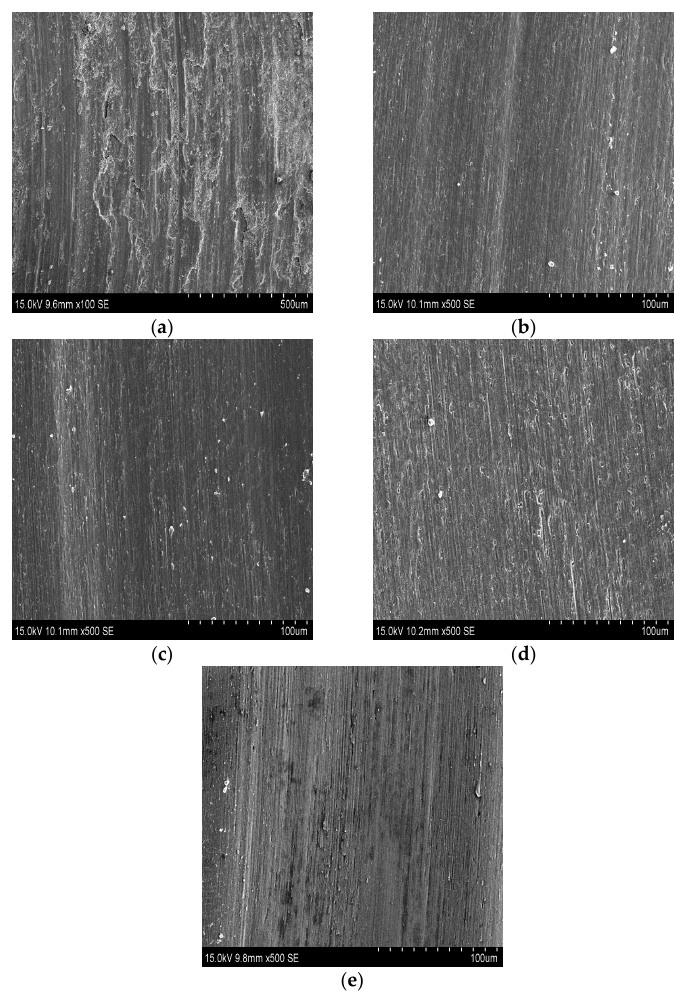
Figure 11. Worn surface morphologies of ( a ) the substrate; ( b ) coating 1; ( c ) coating 2; ( d ) coating 3; ( e ) coating